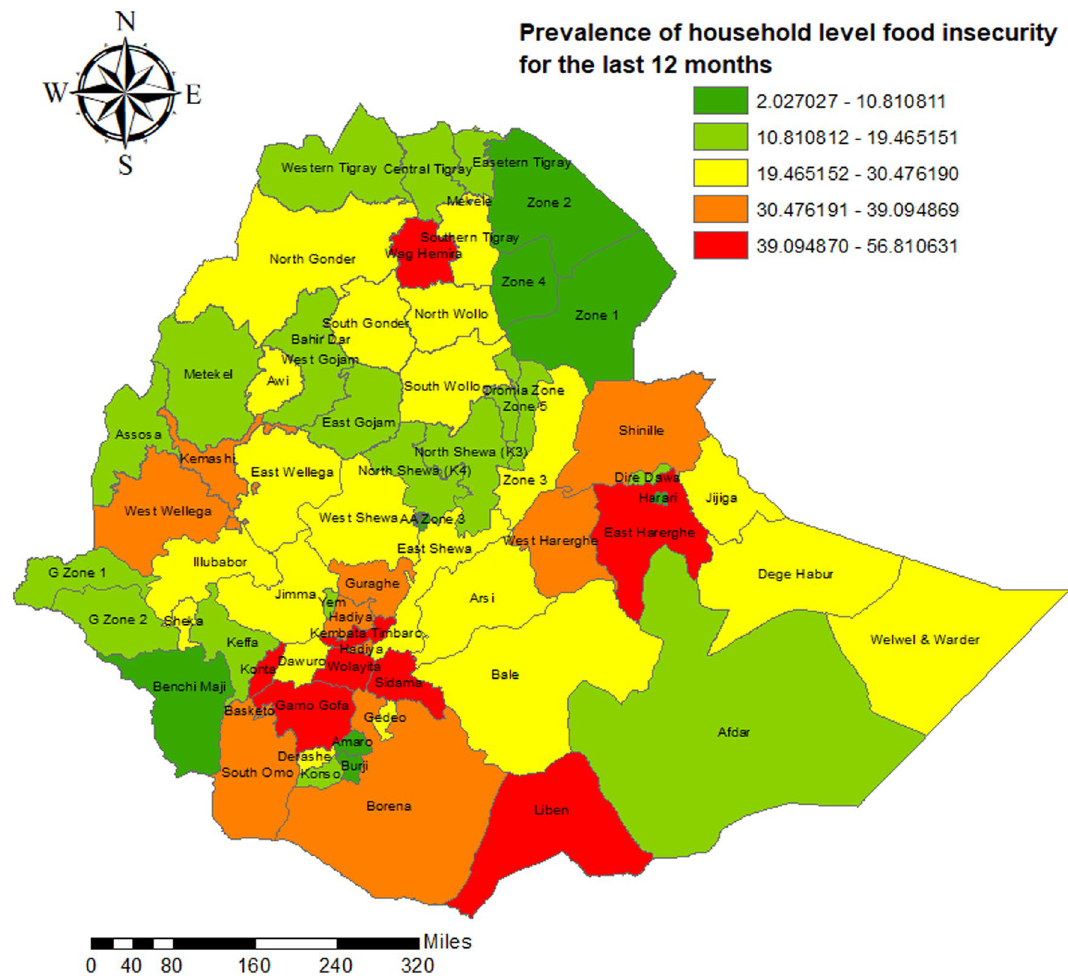
Figure 1. Observed household level food insecurity for the last 12 months across